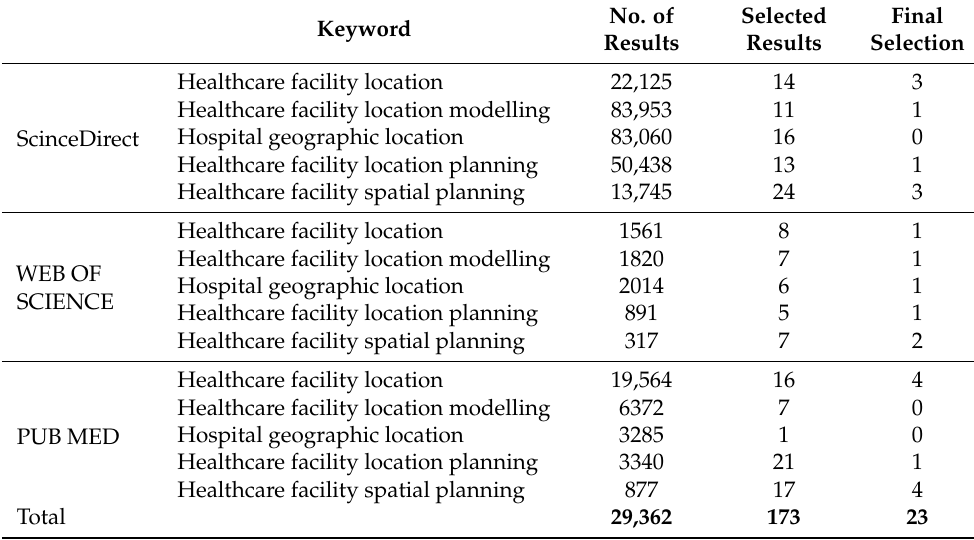
Table 1. The Siting of Healthcare Care Facilities Literature Selected.